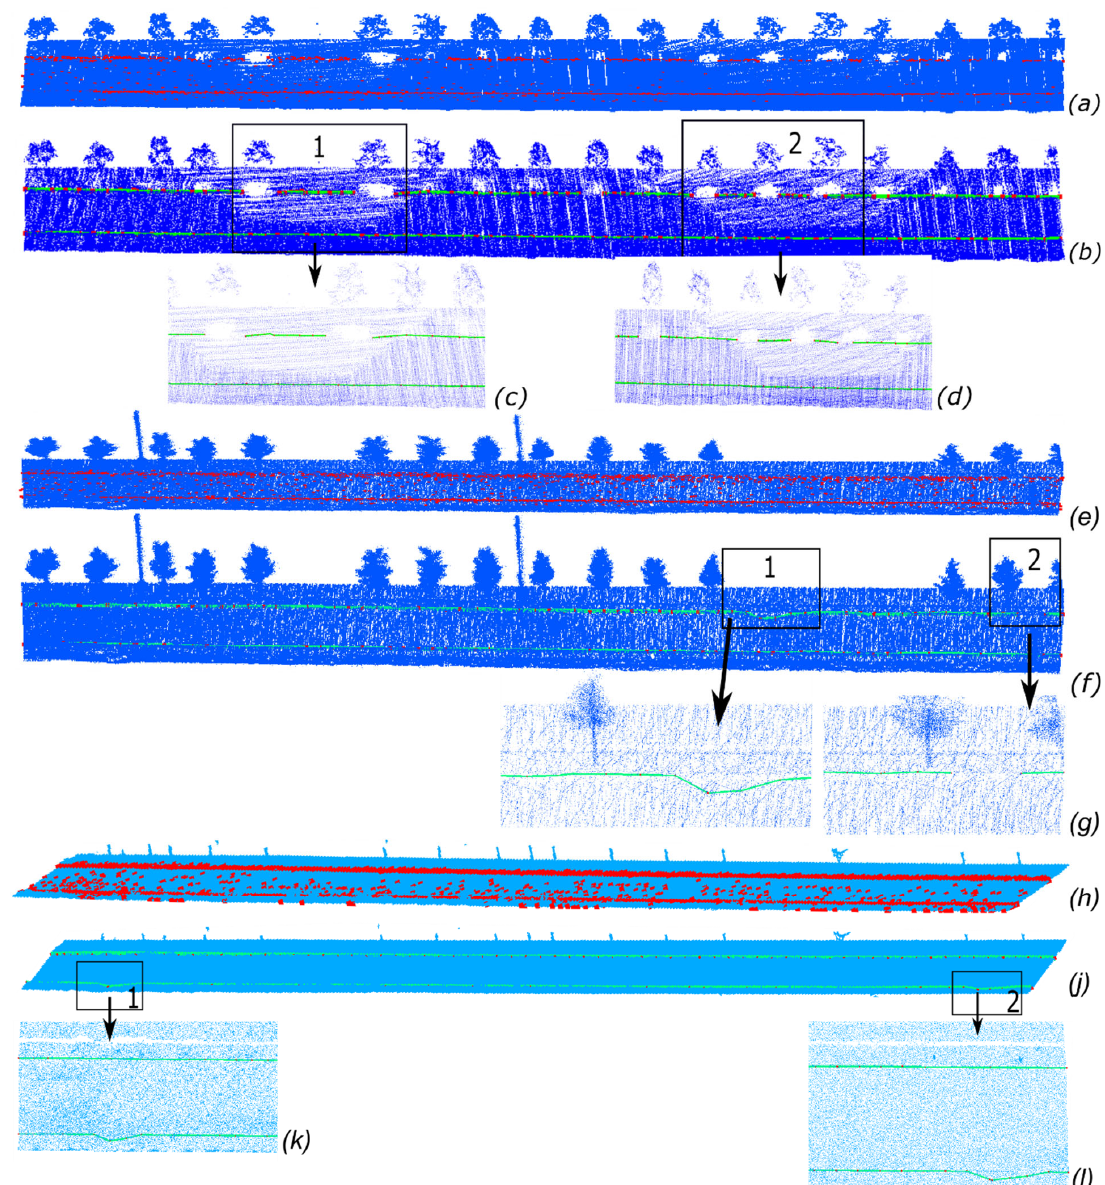
Figure 7: Road boundary extraction results for UAV-LiDAR (a-b-c-d), MLS (e-f-g), and iPhone (h-j-k-l). (a-e-h) shows the initially detected curb points, (b-f-j) shows the refined curb points (in red), and the vectorized road boundary is shown in green. Enlarged images in (c-d-g-k-l) show missing road parts and false curb